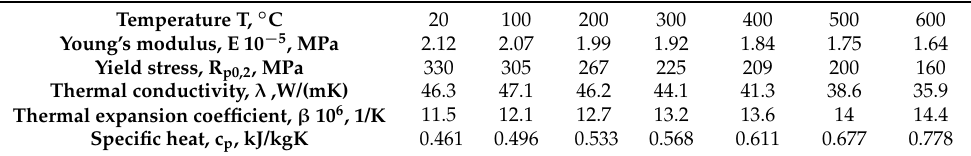
Table 1. Properties of steel grade 14MoV6-3.